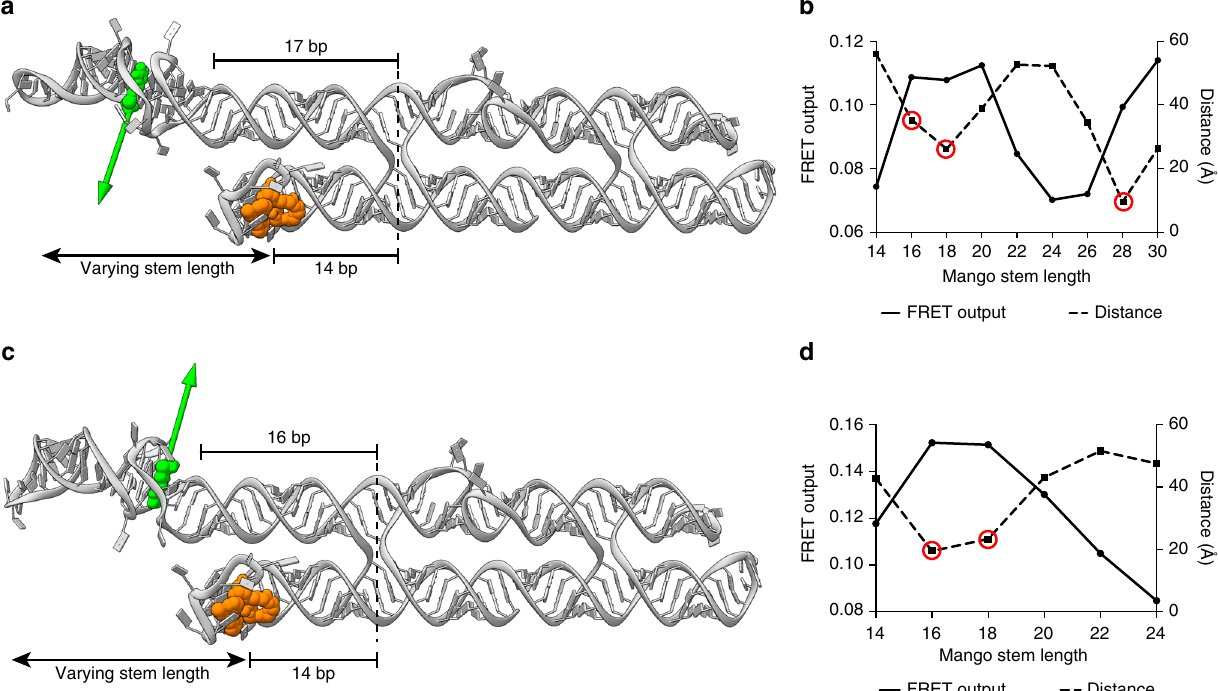
Fig. 2 In fl uence on FRET of dipole moment orientation and distance between Spinach and Mango. a 3D structure of the apta-FRET construct in which Spinach is placed in the construct in its normal orientation. DFHBI-1T (green) and TO1-biotin (orange) is shown in space- fi ll representation, and the calculated dipole moment of DFHBI-1T is shown as a green arrow. As the speci fi c binding of YO3-biotin in Mango is unknown, no dipole moment is indicated. b FRET output of the S17-M14 to S17-M30 constructs (the number after S and M denotes the distance in base pairs between the crossover and Spinach and Mango, respectively). The distances between DFHBI-1T in Spinach and TO1-biotin in Mango measured on 3D models are also shown. The red circles around some distance points denote 3D models in which the Mango aptamer sterically clashes into the stem carrying Spinach. c 3D structure of the apta-FRET construct in which Spinach is placed in the construct in a fl ipped (*) orientation. d FRET output and distances between DFHBI1-T and TO1-biotin of the S*16-M14 to S*16-M24 constructs. Red circles similar to